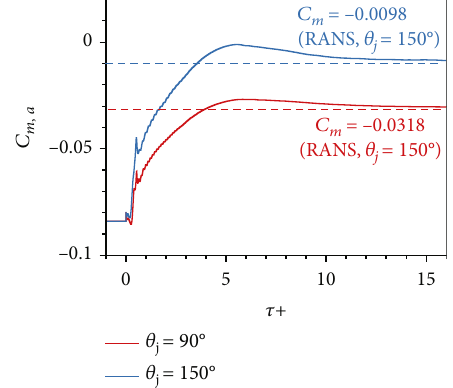
Figure 21: Pitching moment response after jet activation at M = 0 : 729 , α = 3 ° , and C